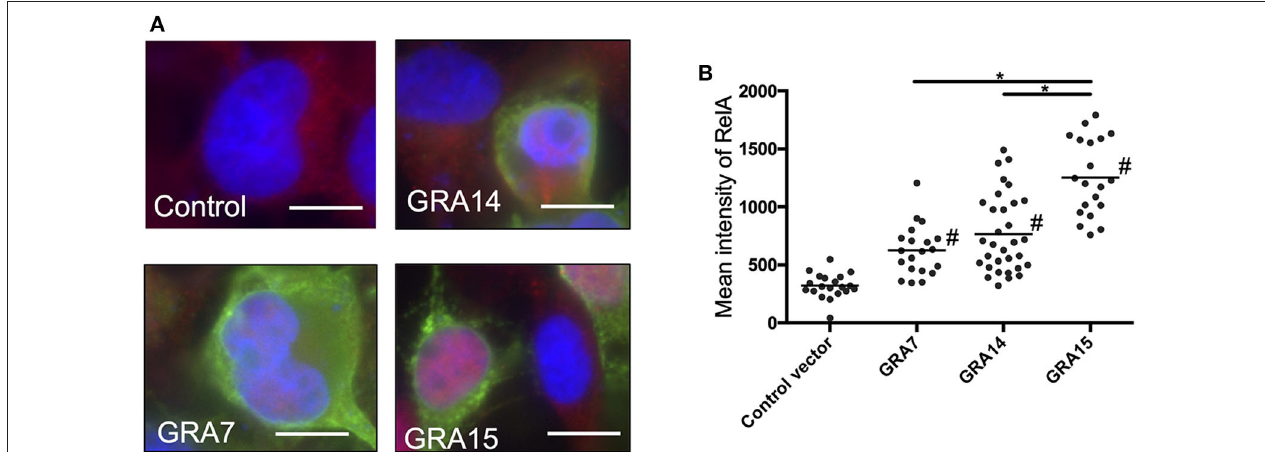
FIGURE 2 | GRA expression activates nuclear translocation of NF- κ B RelA in 293T cells. (A) 293T cells were transfected with the expression vectors for GRA7, GRA14, or GRA15, or the empty p3 × FLAG-cmv14 vector used as a negative (empty) control. Cells were then fixed and stained with α -NF κ B RelA (red), α -FLAG (green), or Hoechst dye (blue). Bars, 10 µ m. (B) The mean intensity of RelA in the nucleus was measured for at least 20 cells per group. Bar indicates the mean of each group, * p < 0.05. #a significantly higher level of nuclear RelA compared with the control cells ( p < 0.05). Differences were tested by one-way ANOVA with turkey’s post-hoc test. Experiments were performed